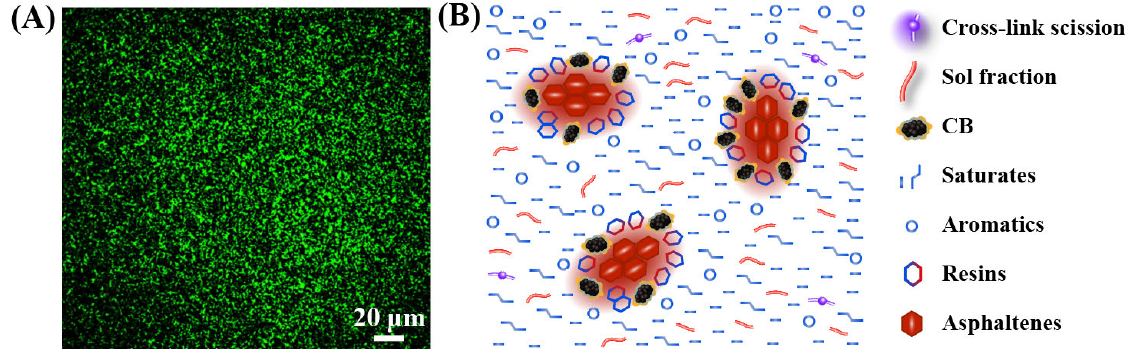
Figure 8. ( A ) Typical morphology of DRMA observed by fluorescence microscopy [46]; ( B ) colloidal structure of micro-nano rubber asphalt.